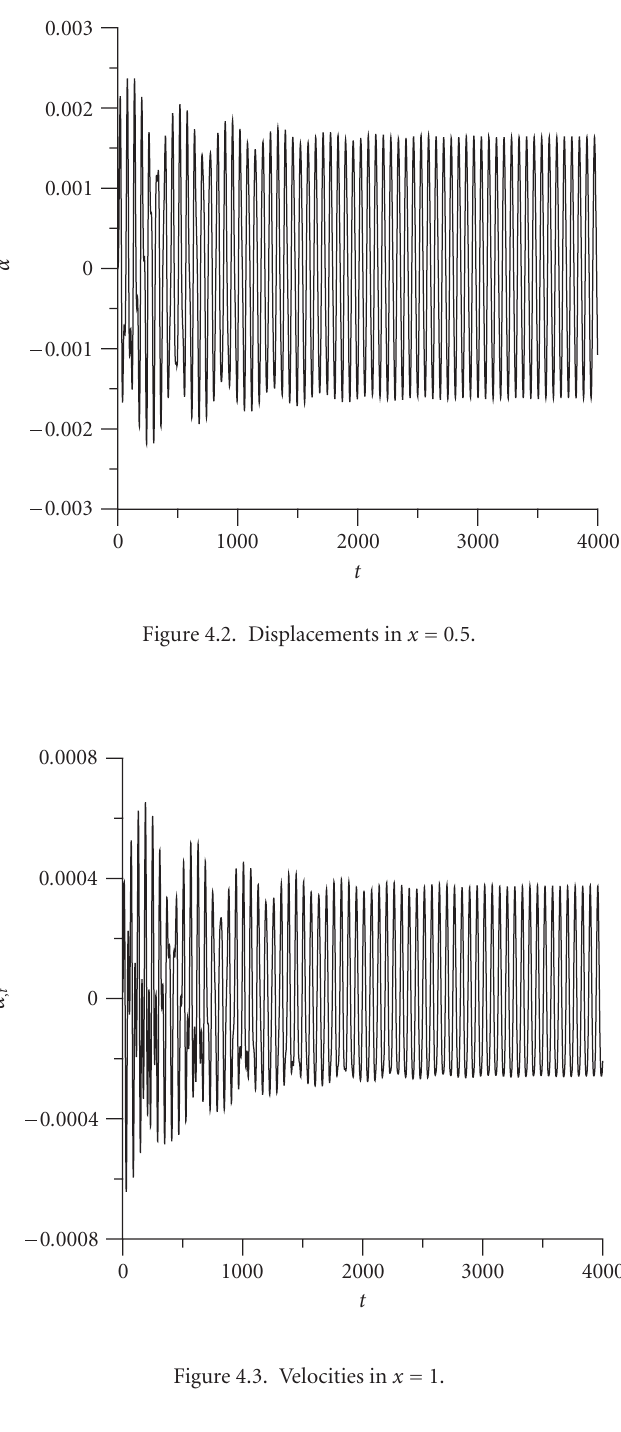
Figure 4.3. Velocities in x =